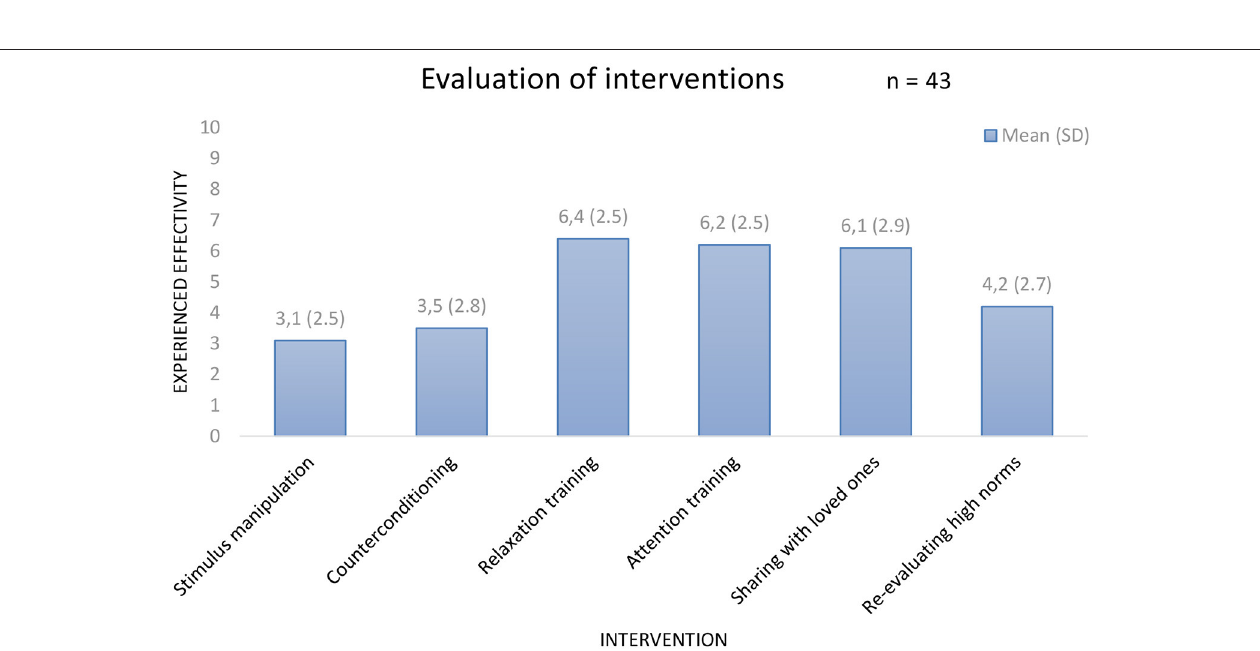
FIGURE 5 | Evaluation of the CBT interventions.